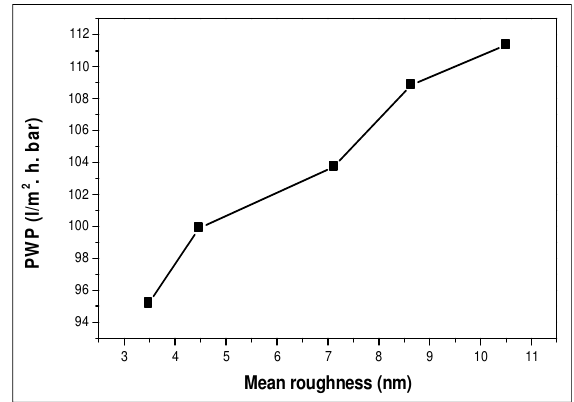
Fig. 7. Accumulative (%) of the pore diameter at the inner surface of the hollow fiber blend membranes.